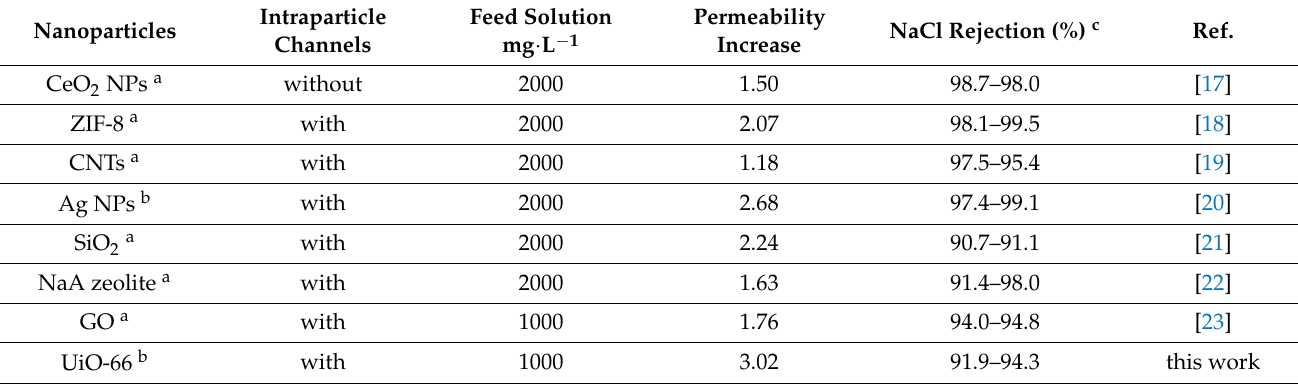
Table 1. Previously published works concerning nanoparticle embedded desalination membranes.